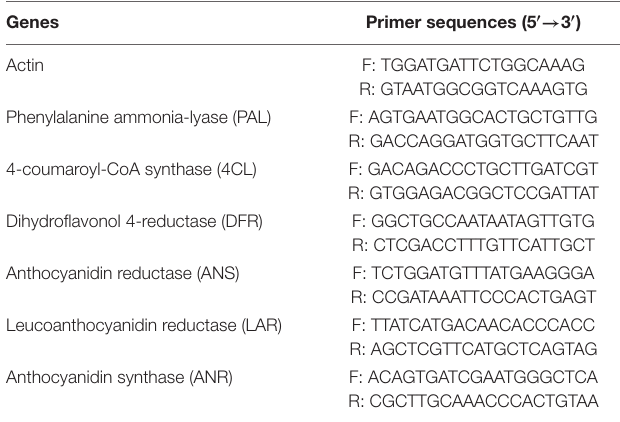
TABLE 1 | Gene sequences used in real-time quantitative PCR (RT-qPCR) procedures.